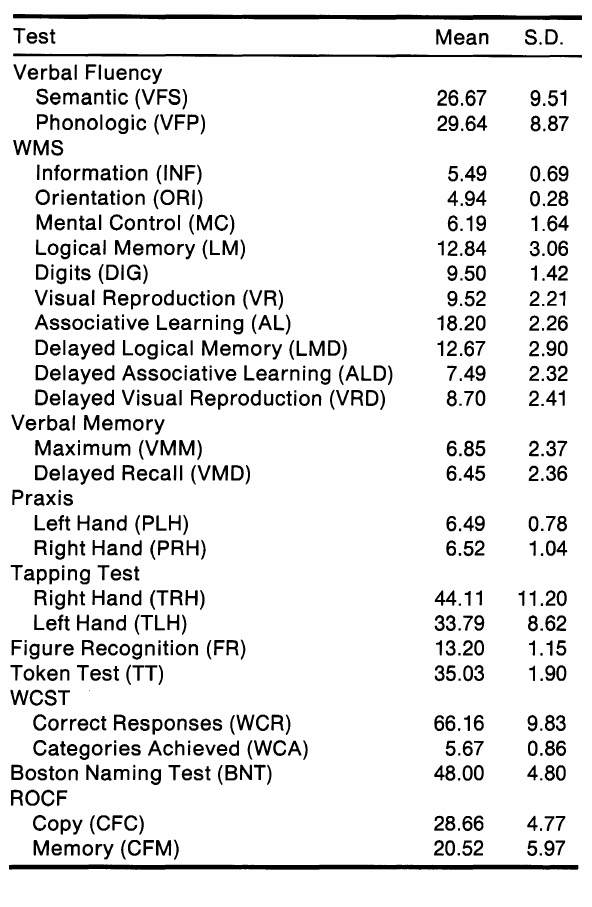
TABLE II. Means and standard deviations found in the different neuropsychological tests in the 98-subject sample